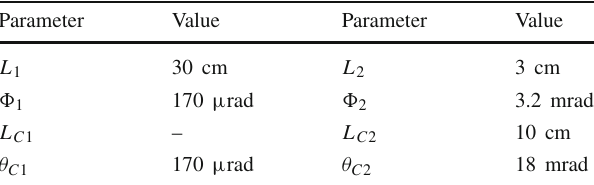
Fig. 2 The protons are focused onto the target by means of a crystal lens of length L C 1 , at a distance L 1 from the center of the target. The interaction products, such as (cid:2) + c particles (red curve), may be chan- neled in a second crystal lens if their direction is parallel to the atomic planes at the crystal entry point. To capture particles produced at differ- ent angles, the lens aperture of the second crystal, (cid:7) 2 , must be at least Table 1 Setup parameters used for the computation of the trapping efficiency with the double-lens scheme. The parameter values are either determined by the physical limitations of the LHC beam, or taken as the optimal parameters from previous studies (see text) Parameter